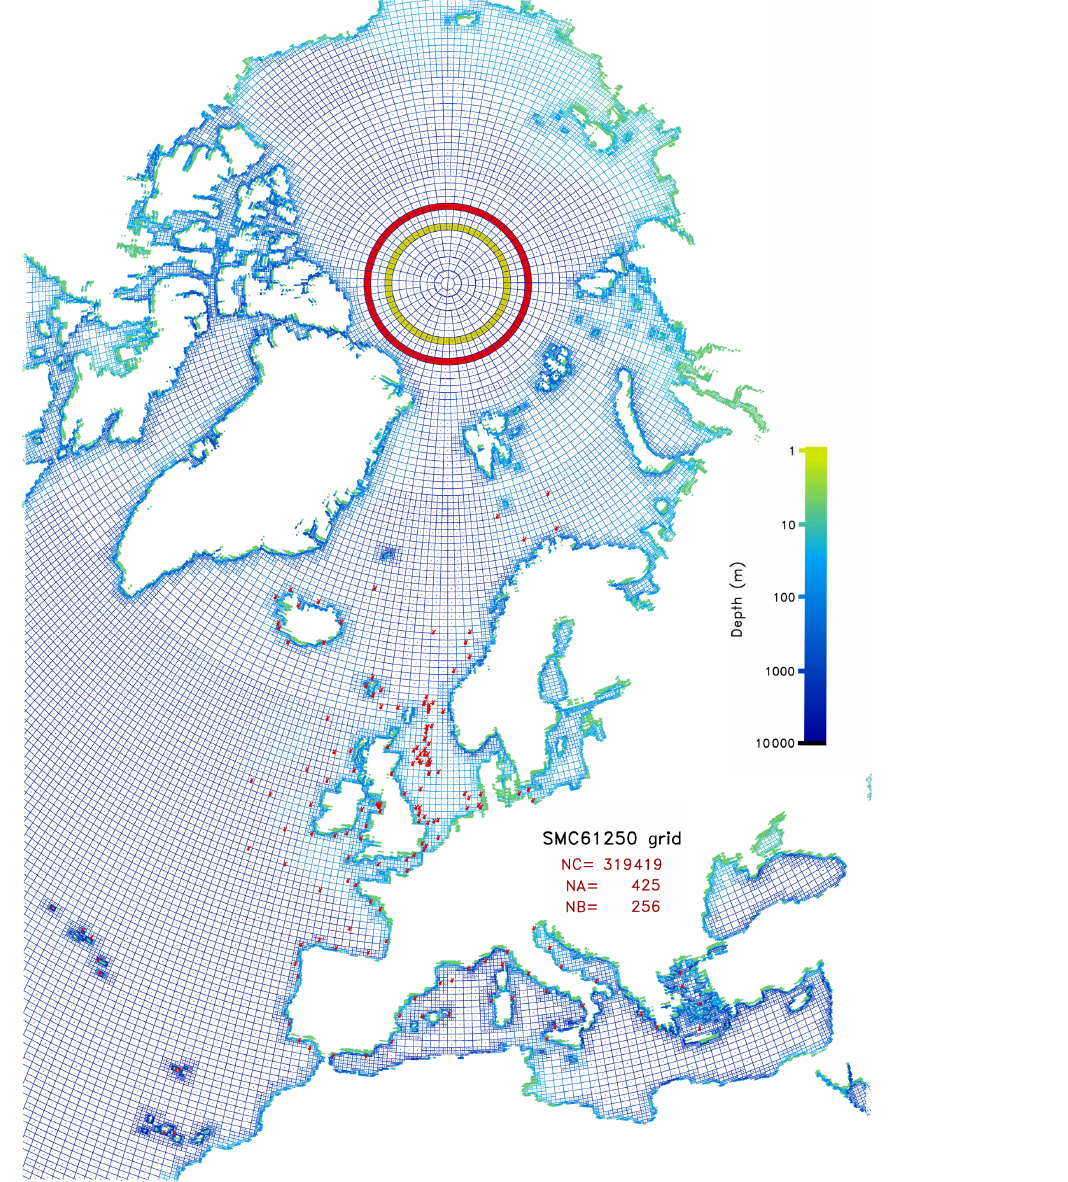
Figure 1. The SMC 6–50km grid.